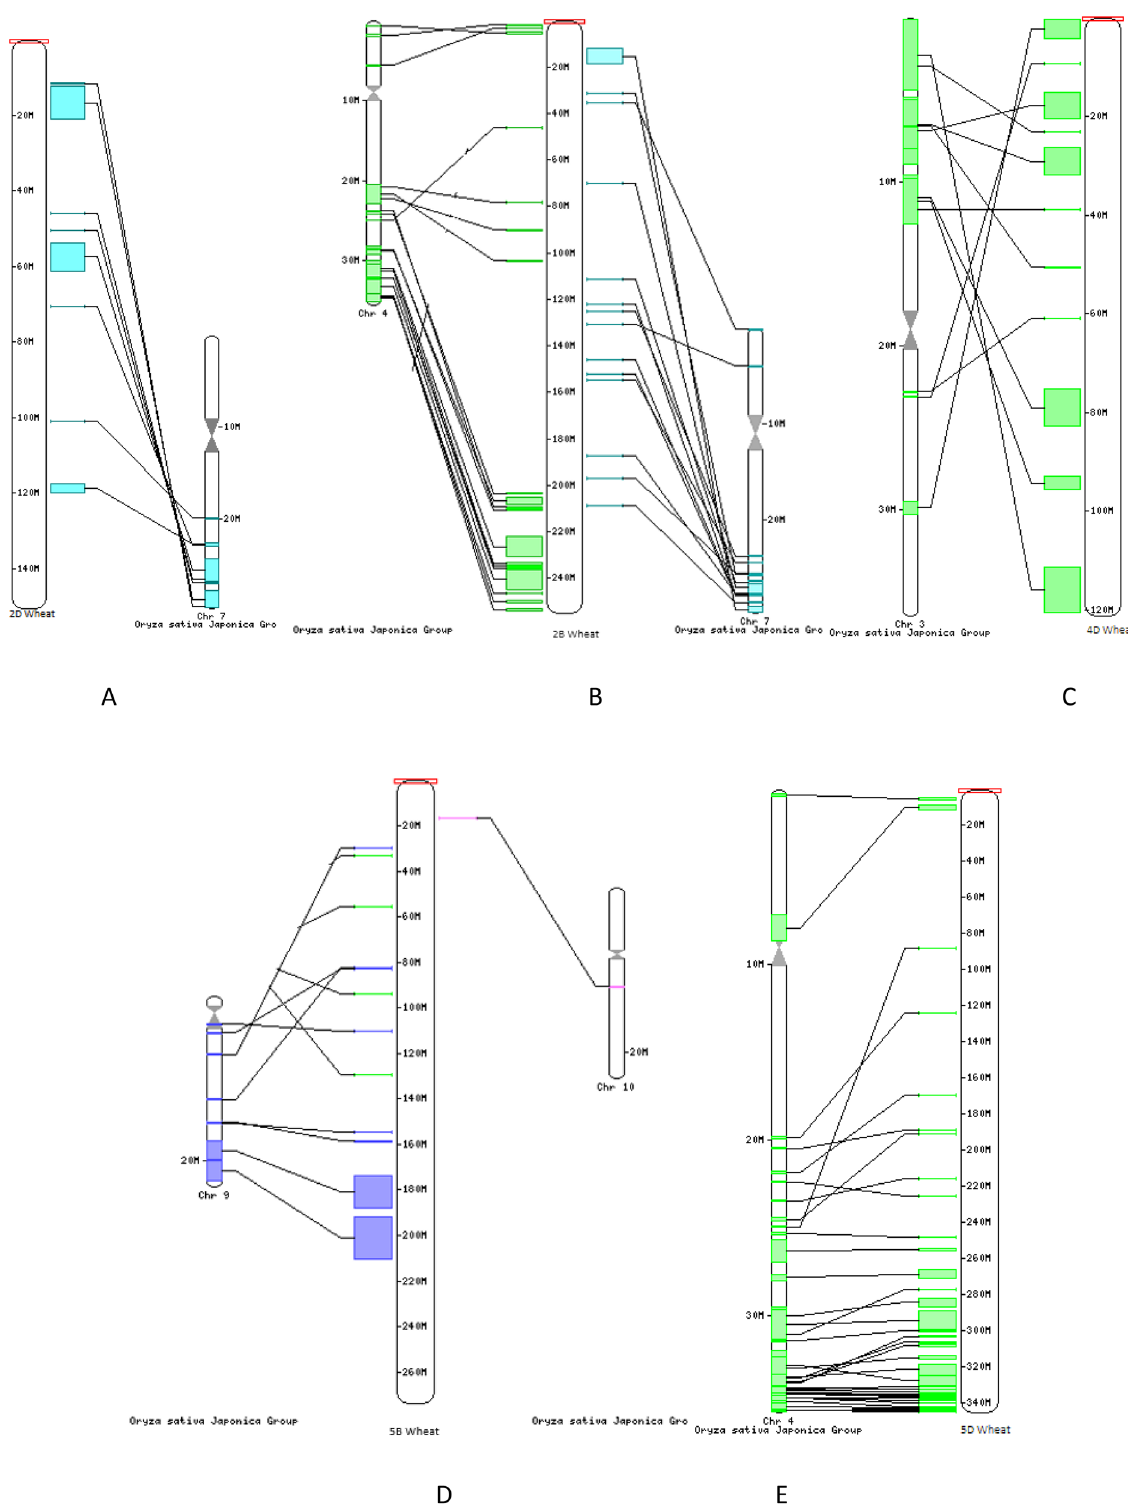
Figure 7. Comparative positional analysis of TaTIFY genes between wheat and rice chromosomes. ( A ) Comparative localization of TaTIFY genes (1, 6, 18, 20) on 2D of wheat and chromosome 7 of rice, ( B ) Comparative localization of TaTIFY genes (2, 10, 13, 16, 19) on 2B of wheat and chromosome 4 and 7 of rice, ( C ) Comparative localization of TaTIFY genes (3, 4, 5, 12) on 4D of wheat and chromosome 3 of rice, ( D ) comparative localization of TaTIFY genes (7, 8, 9, 17) on 5B of wheat and chromosome 9 and 10 of rice, ( E ) Comparative localization of TaTIFY21 on 5D of wheat and chromosome 6 of